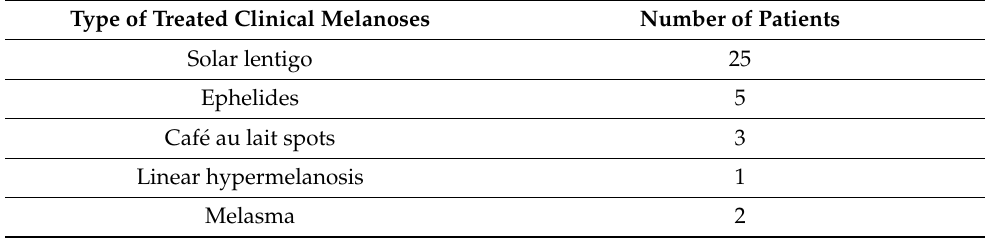
Table 3. Types of melanoses